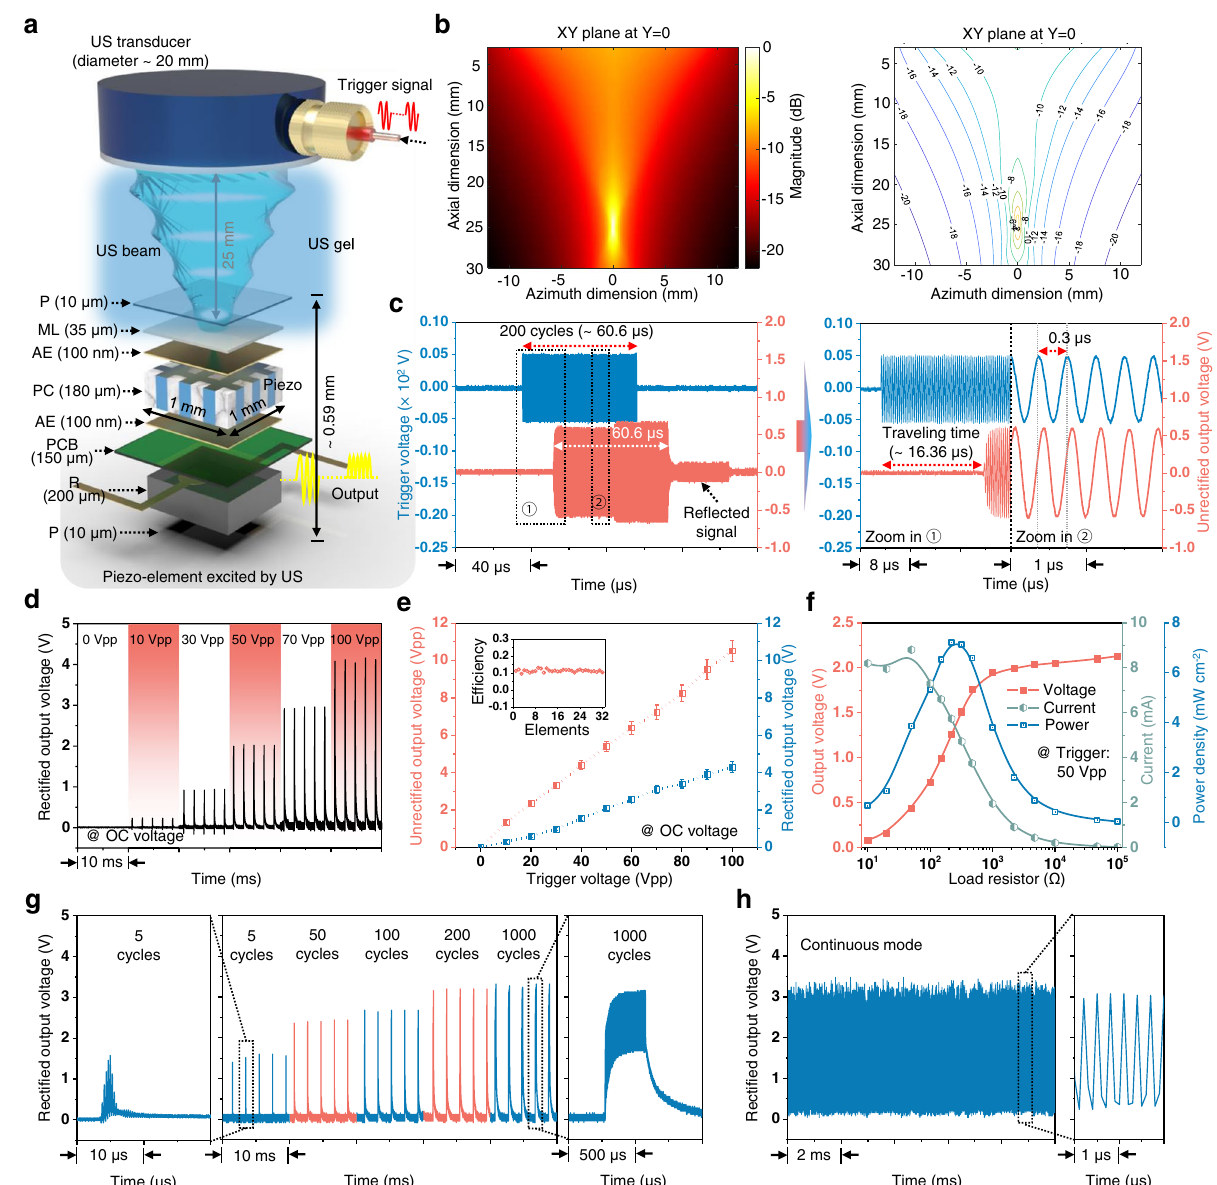
Fig. 3 Simulation and characterization of US-induced electrical outputs. a Schematics of an US-induced measurement setup, with a 3.3-MHz focused probe as US transmitter and with key components and aspect ratios labeled. b Simulated US fi eld emitted by the focused probe using a Field II software package, showing a spatially con fi ned US beam. The color bar indicates the magnitude distribution of acoustic pressure. c Comparison between the trigger signal used to excite the transducer and the unrecti fi ed output signal from the F-URSP. d Recti fi ed output voltage magnitudes generated from the F-URSP using different trigger voltages. e Unrecti fi ed and recti fi ed output voltages against the trigger voltages. N = 32 measurements of independent piezoelectric element. Data were presented as mean ± SD. Inset: The voltage ef fi ciency variation of the 32 piezoelectric elements. f Output voltage, current, and corresponding power density of a piezo-element under a trigger voltage of 50 Vpp and various external loads. g Output voltages under the excitation of trigger signals with different repeat cycles (5 – 1000). h Output voltage under continuous mode. The results demonstrate that the US-induced energy can be fl exibly adjusted by varying the duty cycles. Source data are provided as a Source data fi